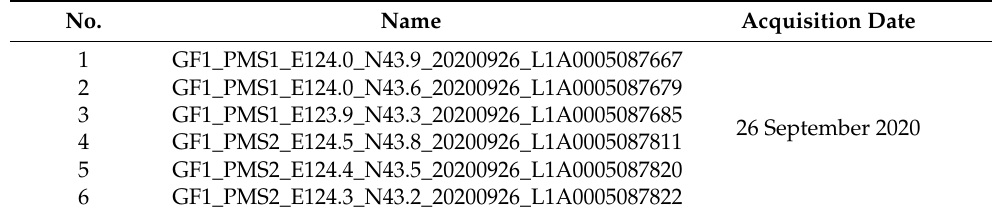
Table 2. Characteristics of GF-1 PMS images used for corn lodging identification.